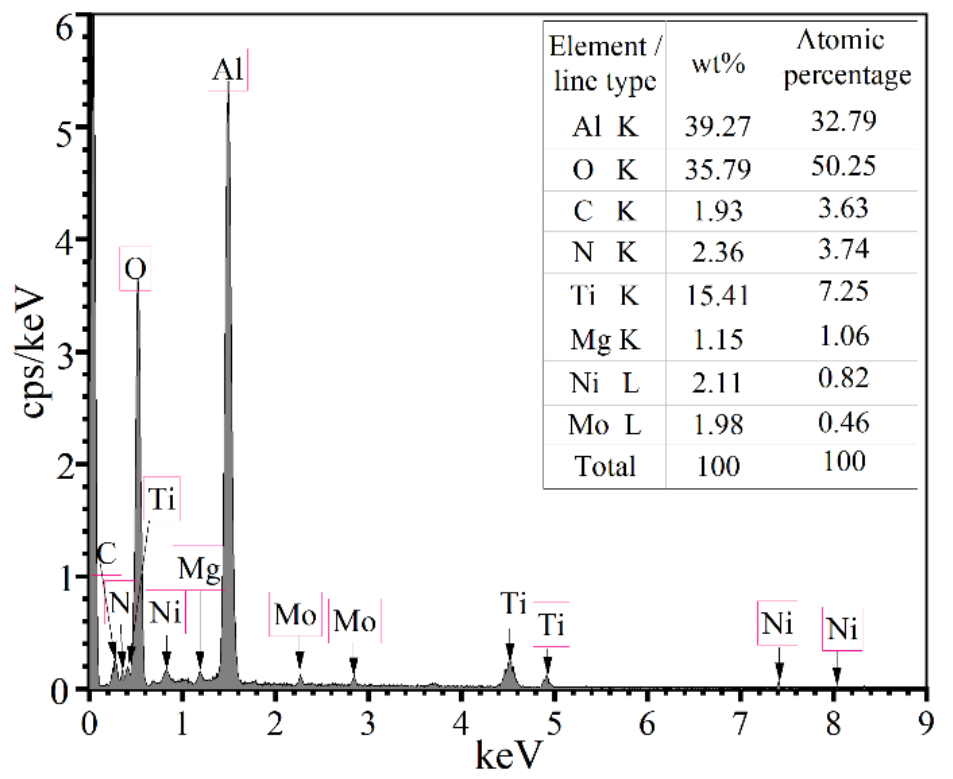
Figure 3. The EDS of Sn-x type Al 2 O 3 composite ceramics.